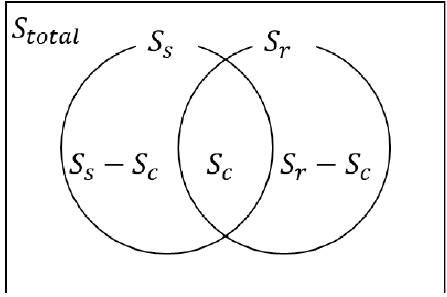
Figure 7. Procedure to estimate image coincidence.